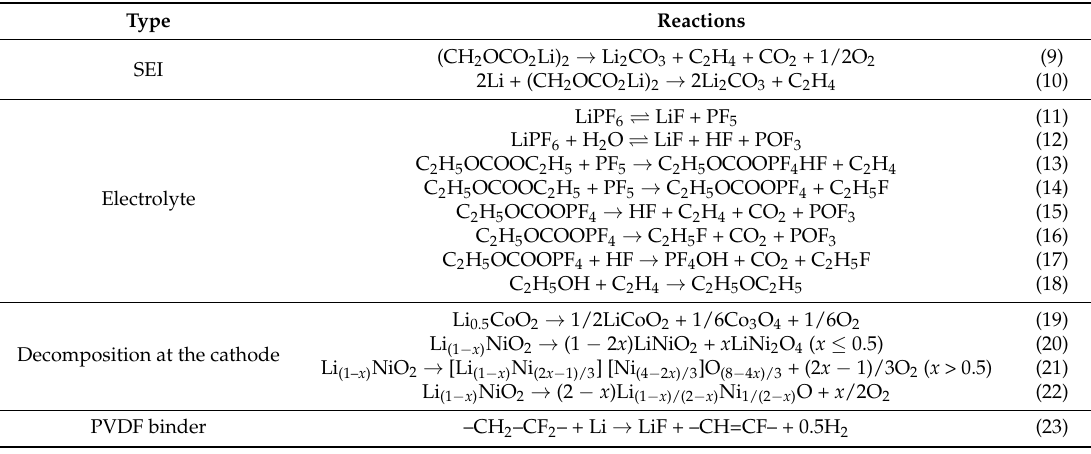
Table 2. Main thermal degradation reactions of Li-ion batteries (LIBs) in cathode (based on